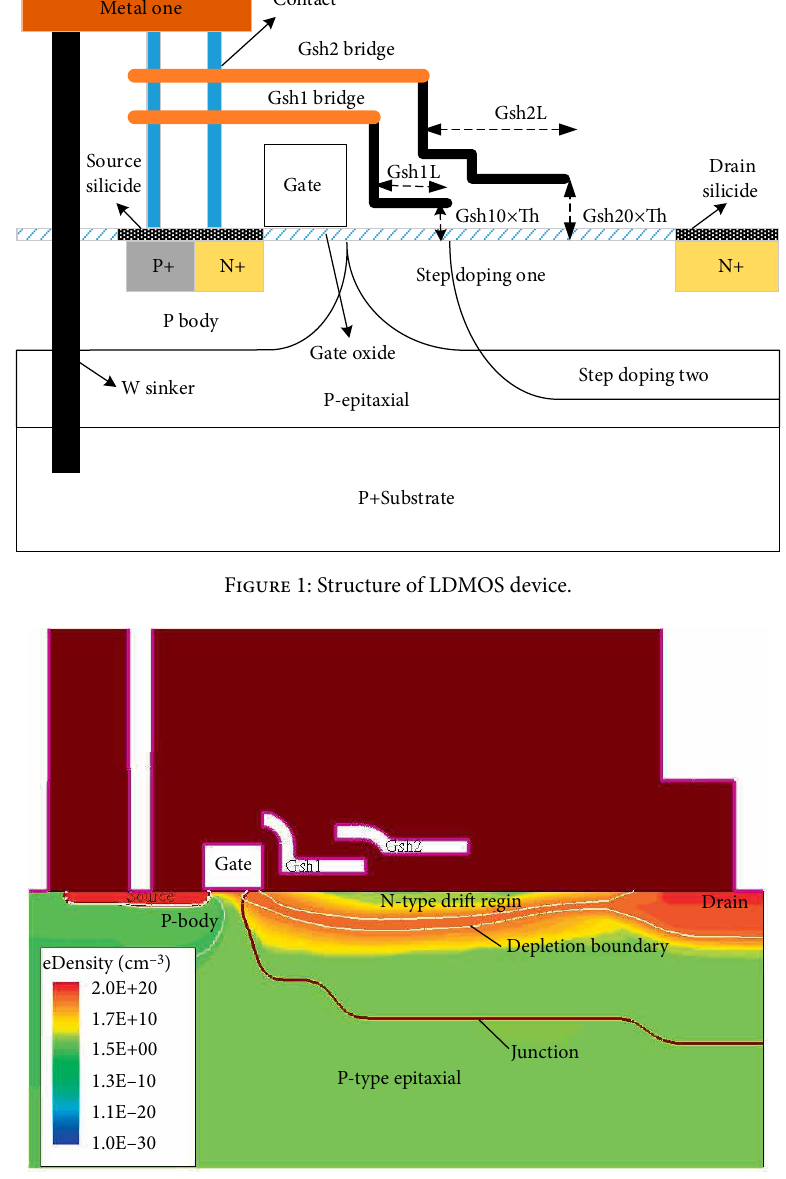
Figure 2: Electronic density at HCI stress condition.